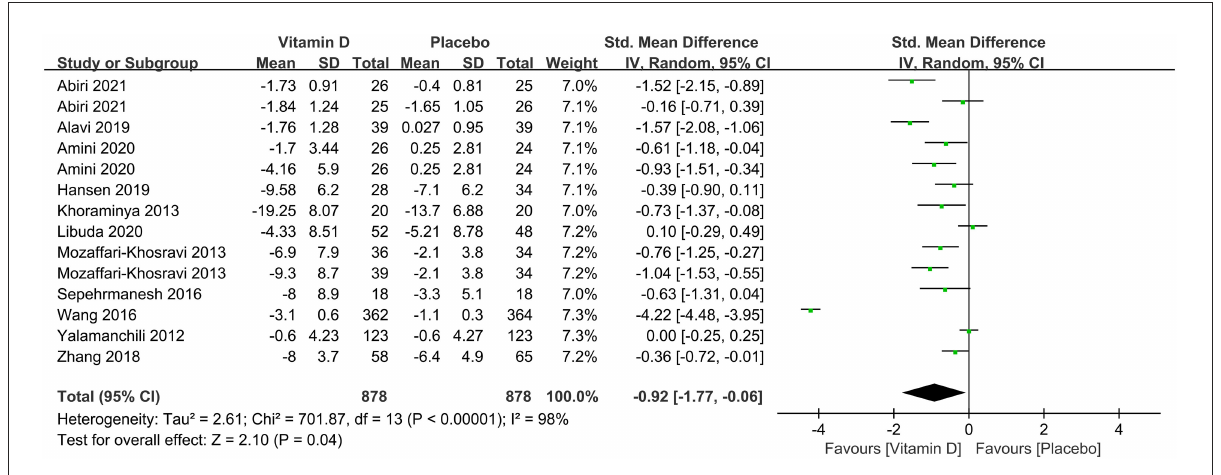
FIGURE5 Forest plot of the correlation between vitamin D and the prognosis of depression.